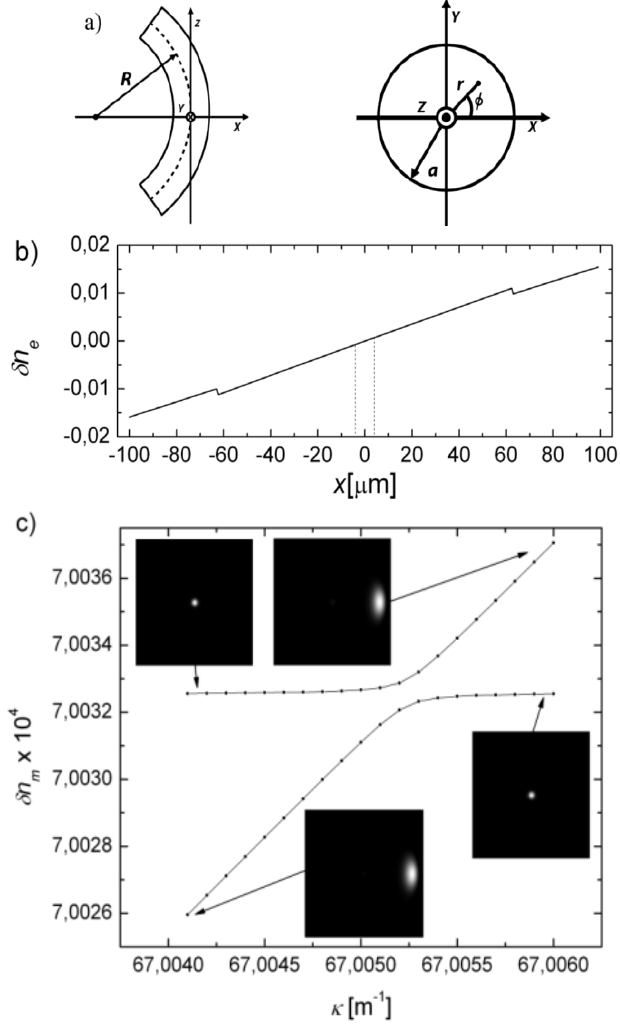
Figure 1. ( a ) Geometry of bent fiber. ( b ) Refractive index perturbation for a bending radius of 6.35 mm; the position of the core is indicated with two dotted lines. ( c ) First resonant coupling predicted by theory as a function of curvature; the insets show the mode intensity patterns of the two coupled modes in a box of 133 × 133